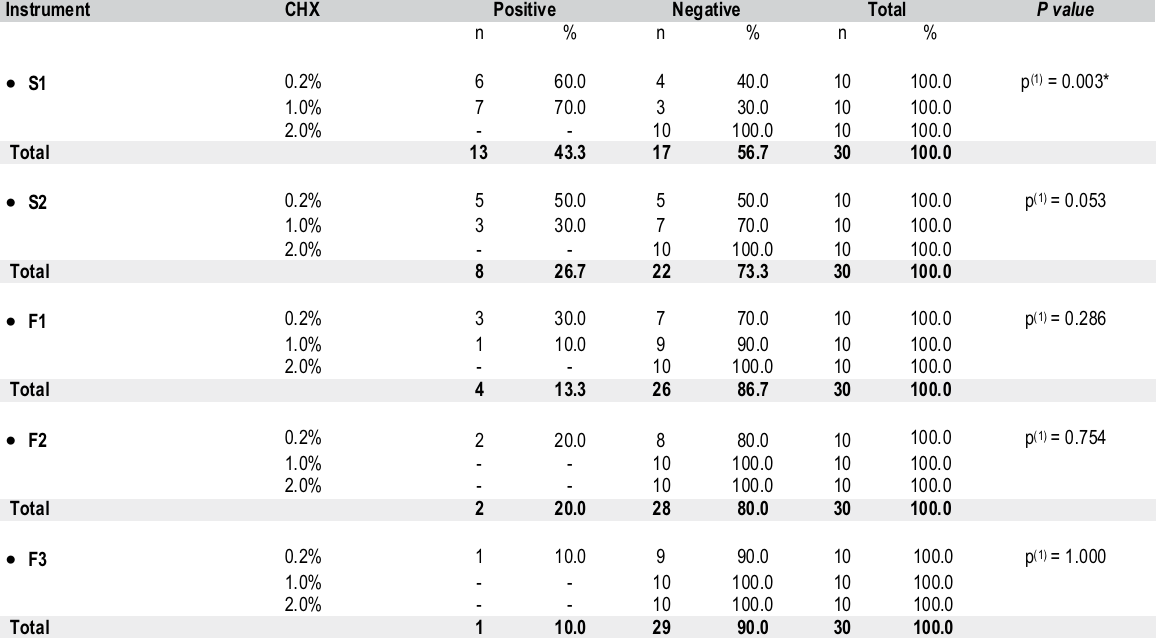
Table 3. Antimicrobial efficacy of 0.2%, 1%, and 2% CHX in root canals infected by C. albicans